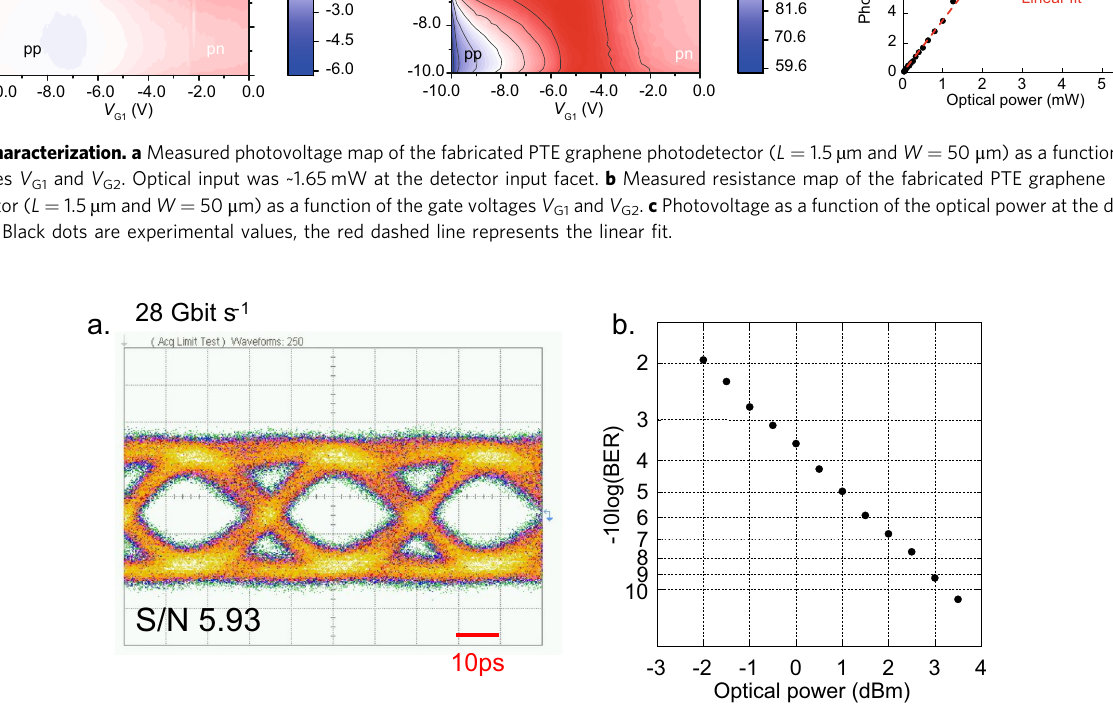
Fig. 4 Detection of an optical data stream at 28 Gb s − 1 . a Eye diagram collected for a 28 Gb s − 1 NRZ OOK data stream at the input of the PTE graphene photodetector. The optical power at the input facet of the photodetector was 2 mW. b BER curve as a function of the optical power at the input facet of the detector. In both measurements, an electrical RF ampli fi er with 23 dB gain and 35 GHz bandwidth has been